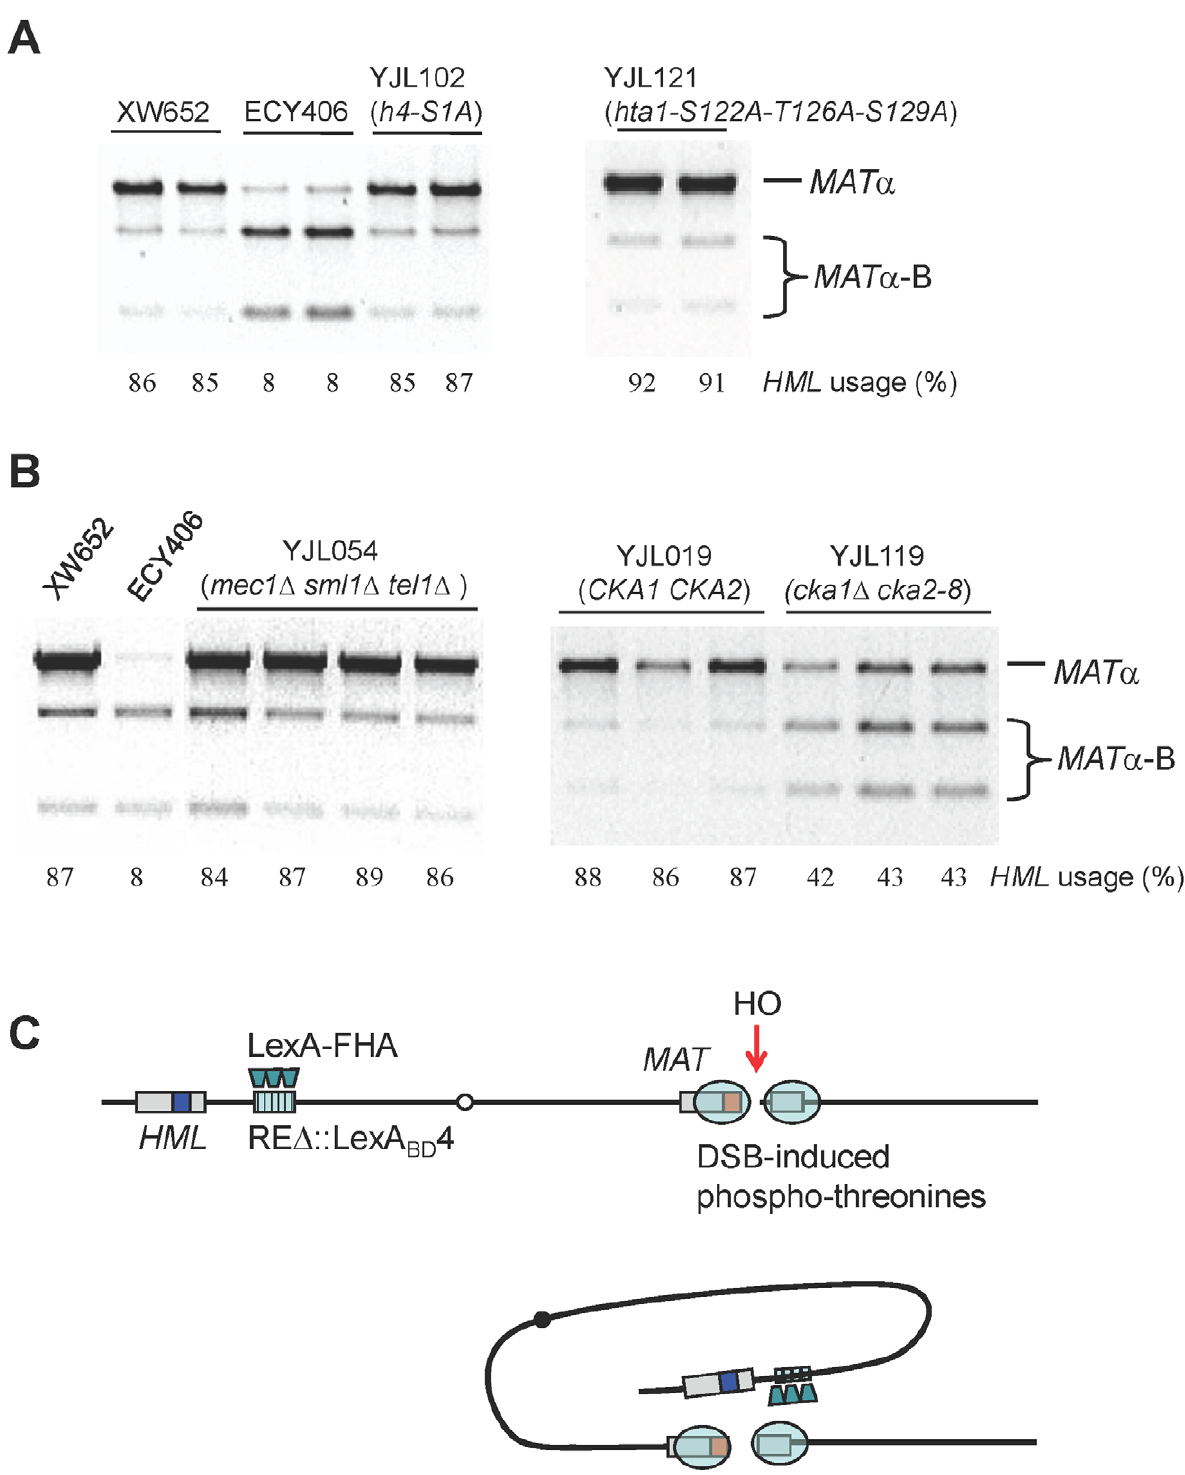
Figure 7. Roles of Histones and Kinases in Donor Preference and a Model for FHA-Directed Regulation. (A) The effect of H4 or H2A phosphorylation sites on donor preference. HML usage was not altered in strains only containing mutated h4-S1A or hta1-S122A-T126A-S129A . Donor preference was measured using a PCR-based assay (Figure 1B). (B) The effect of Mec1/Tel1 or casein kinase II on donor preference. In a triple mutant strain (YJL054), donor preference is not different from wild-type control (XW652). The cka1::KAN , cka2::NAT , pRS315- cka2-8 (ts) are crossed into YJL019 (Figure 3A) to generate the YJL119 strain. Both strains are first cultured at 25 u C for overnight and then transferred to 37 u C for 3 hour incubation. Galactose induction is performed for 1 hour and stopped by the addition of 2% dextrose. (C) A model for FHA-directed regulation of donor preference. After the generation of a DSB at MAT a , we propose that a physical interaction between the FHA domain of Fkh1 and phosphothreonines of histones or bound proteins around the MAT will bring HML to the vicinity of the DSB, therefore allowing HML to serve as the favored template for DSB repair. The tethering of HML approximately 20 kb from the MAT can account for an almost 10-fold preference of HML usage over HMR . doi:10.1371/journal.pgen.1002630.g007 PLoS Genetics |